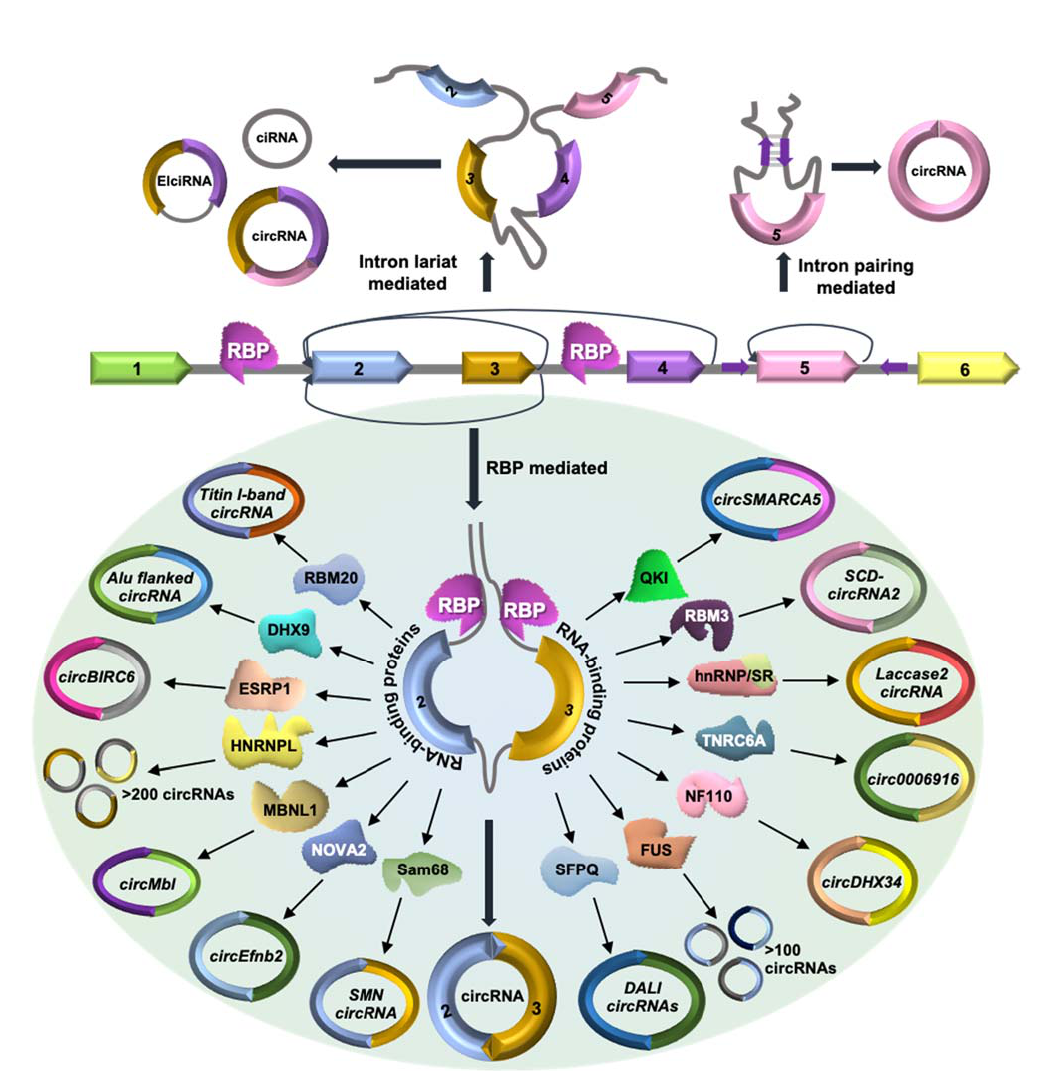
Figure 1. Schematic representation of circRNA biogenesis. Exonic circRNA is formed through a lariat ‐ mediated or intron pairing ‐ mediated backsplicing mechanism, where the downstream 5 ′ splice donor site of one exon covalently joins the upstream 3 ′ splice acceptor site. Backsplicing of circRNAs without splicing generates EIcircRNAs with a retained intron. The intronic lariats resistant to debranching generate stable ciRNAs. In addition, RBPs interacting with pre ‐ mRNA can modulate the backsplicing of circRNAs.